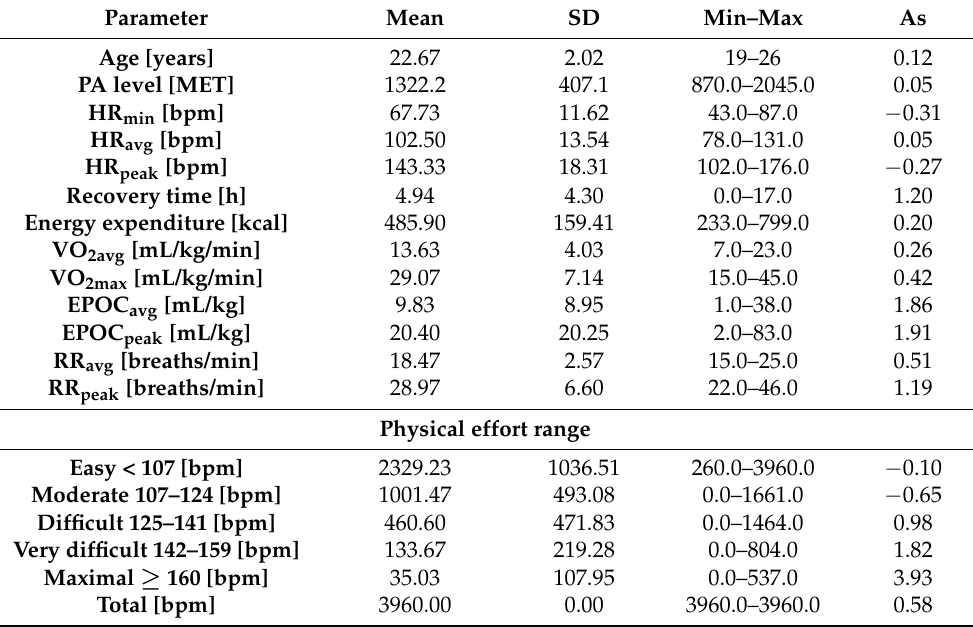
Table 1. Physiological parameters during sauna (66-ME).